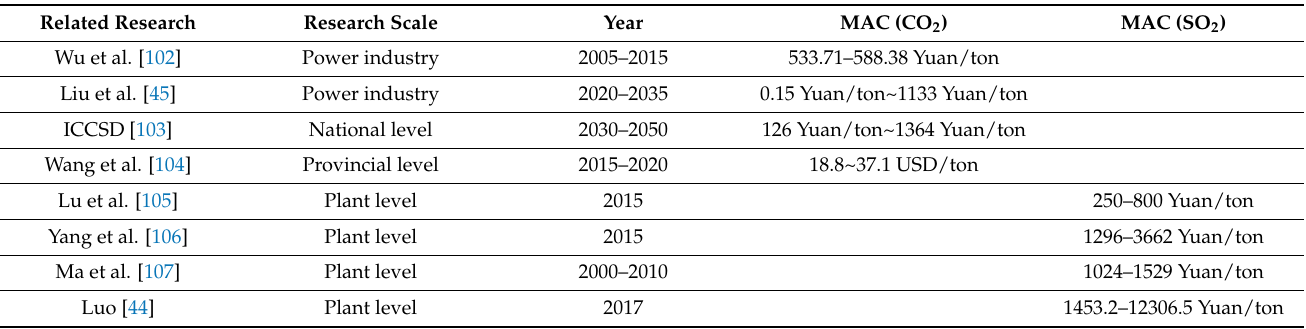
Table A3. The reference value of MACs of CO 2 and SO 2